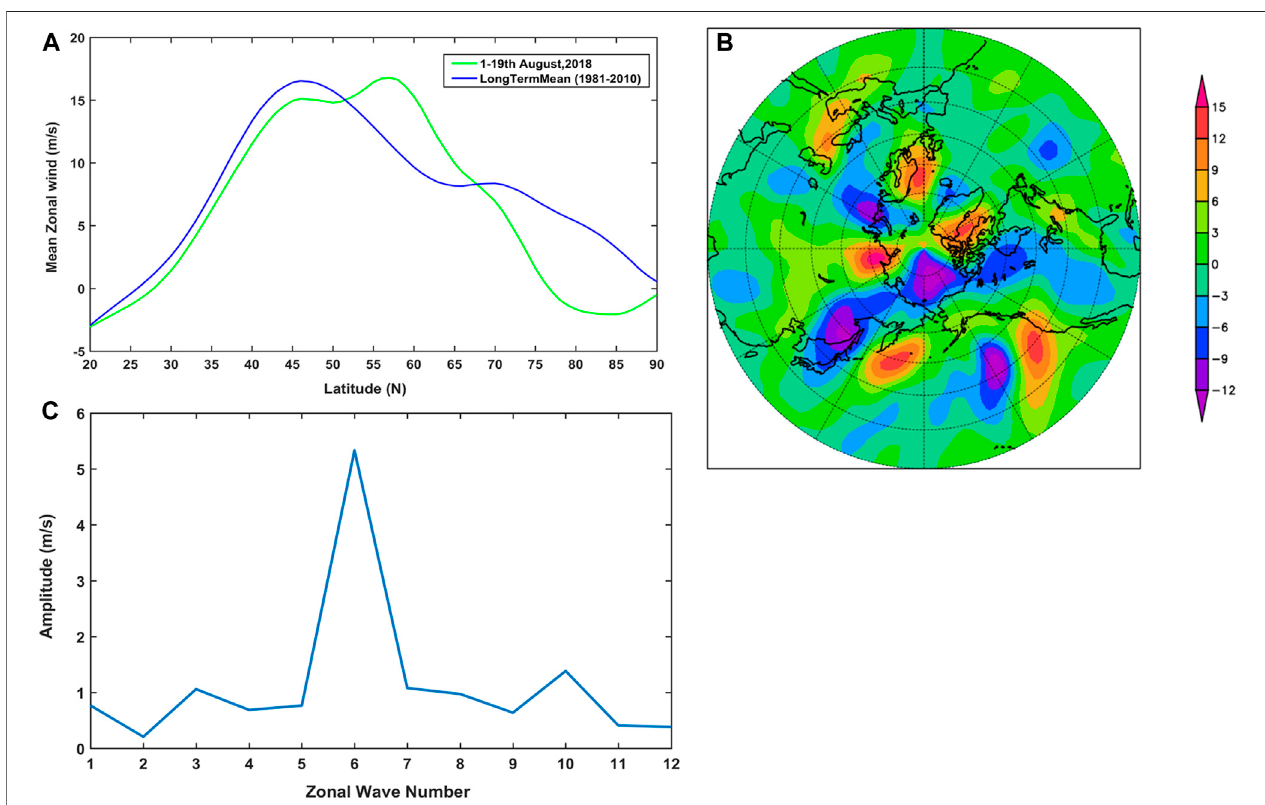
FIGURE5|(A) Meridionalvariationsofupper-troposphere(300hPa)zonalmeanzonalwindsoverNH (B) Circumglobalvariationsofupper-troposphere(300hPa)meridional wind fi elds over NH and (C) Zonally averaged zonal wave number spectra for the meridional wind fi elds at 300 hPa over 37.5 ° to 57.5 ° N for the period 1st to August 19,